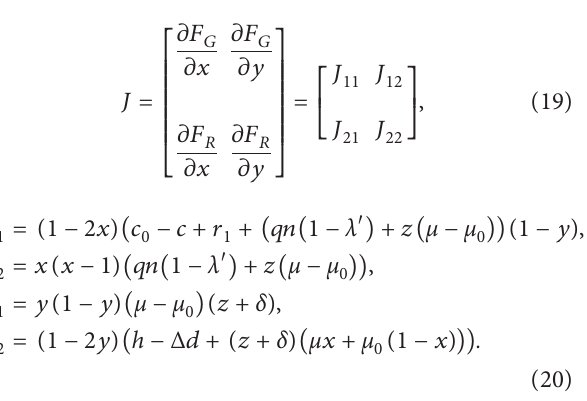
Figure 2: Replication dynamic phase diagram of the real estate